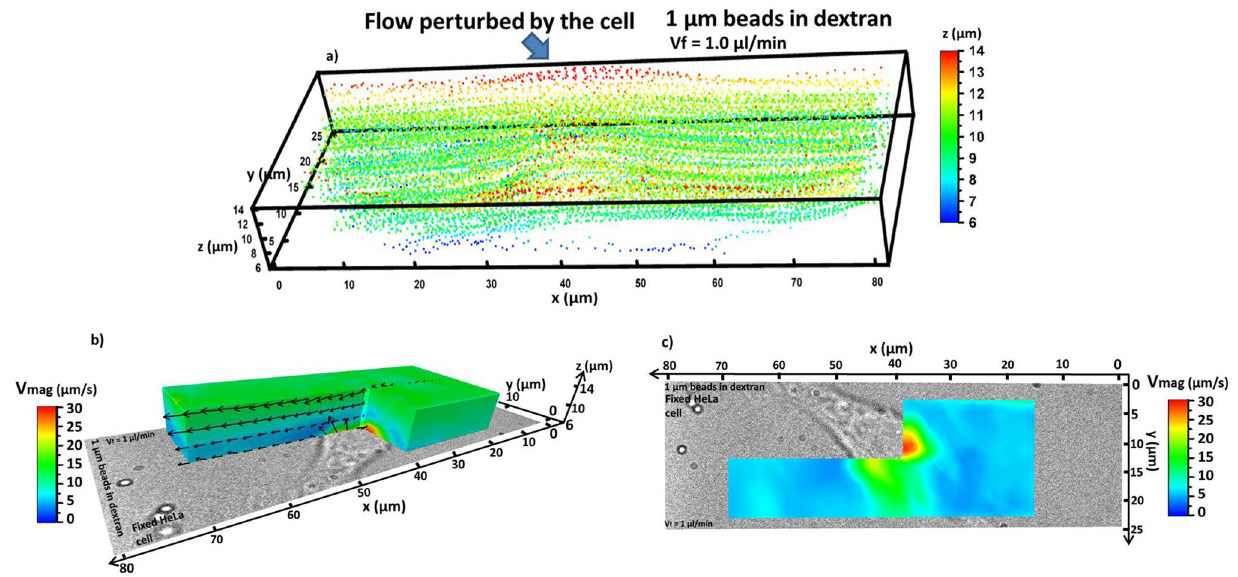
Figure 3. ( a ) 3D plot showing all localised 1 µm beads in dextran flowing over the selected HeLa cell. The perturbation to the flow generated by the cell is indicated. The axial positions are colour encoded in the plot. ( b ) Side view of the 3D map of the velocity magnitude associated to the fluid of 1 µm beads in dextran flowing around the fixed HeLa cell. The fluid flows from right to left along the x axis. ( c ) Bottom view of the velocity map in ( b ).